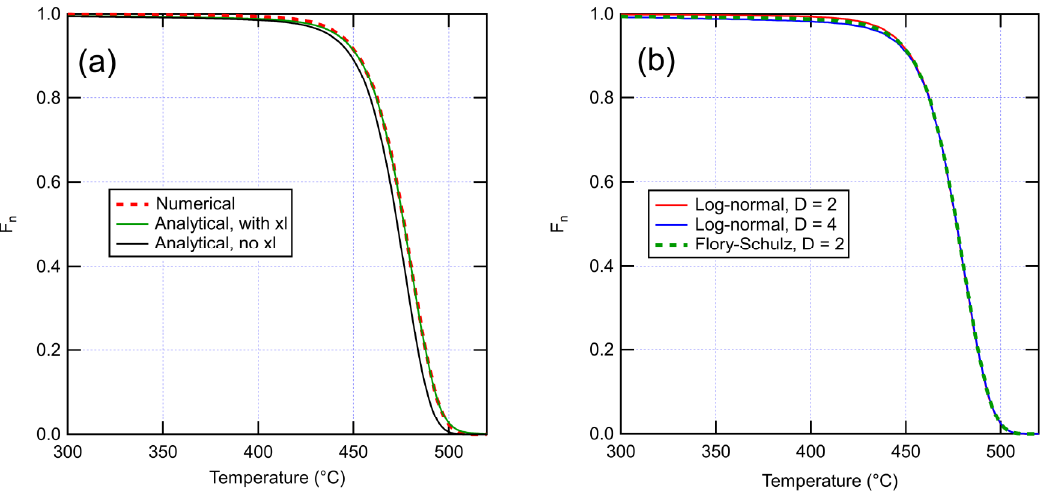
Figure 1. ( a ) Comparison of numerical and analytical TGA curves. Numerical curve is for a system of 10 5 monomers with 700 chains and 615 cross-links (corresponding to M w = 4000 g/mol, ρ xl = 0.4 mol/l). Analytical curves are for the same system with and without crosslinks. ( b ) Effect of dispersity on the numerical TGA curves. Results are shown for dispersity of 2 sampled from both log-normal and Flory–Schulz distributions with the same M w , and dispersity of 4 sampled from log-normal distribution. Here, the scission rate r sc is taken to follow an Arrhenius law with the constants A = 1.00 × 10 14 s − 1 and E = 248 kJ/mol. Numerical results are averaged over 100